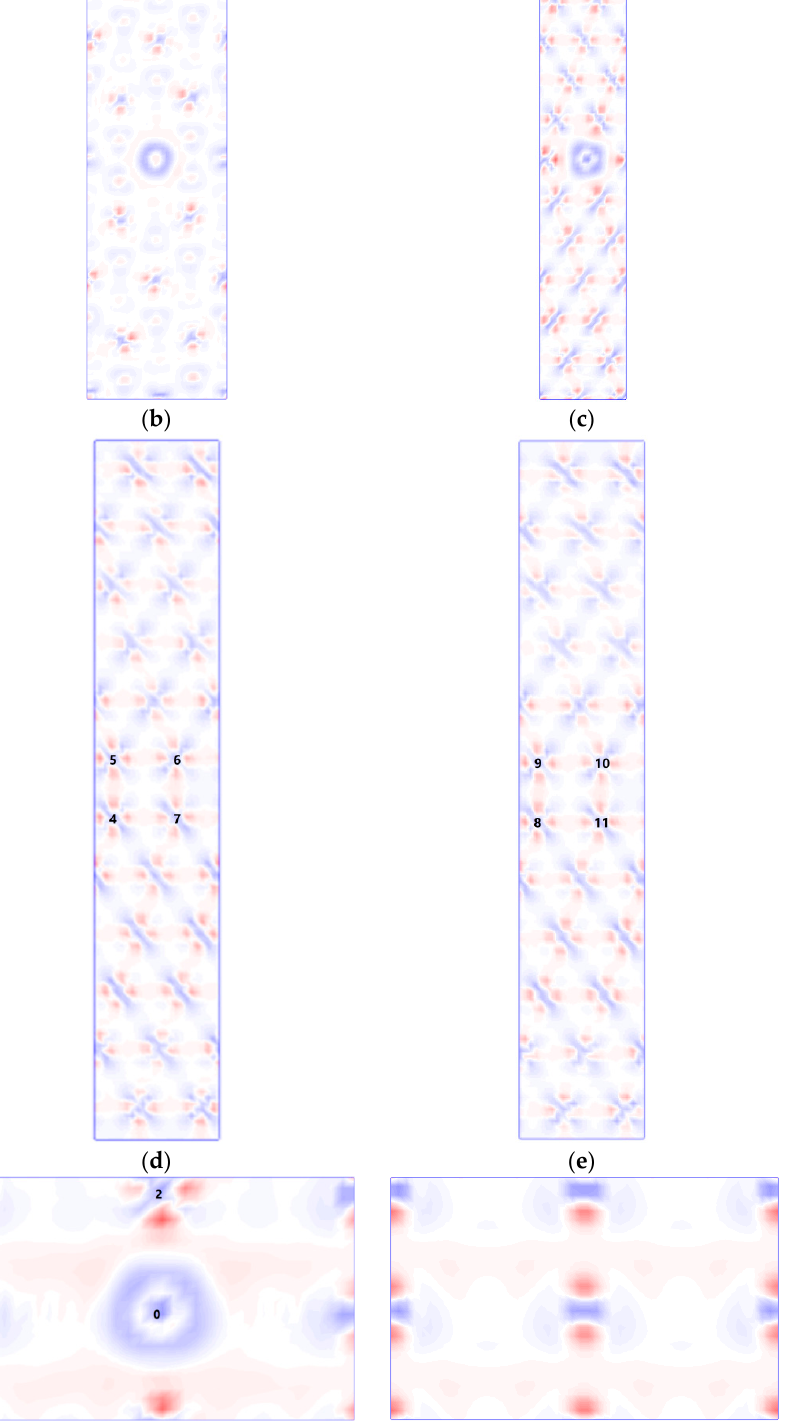
Figure 1. ( a ) The atomic configurations of bcc Fe for Σ 3[110] (112) grain boundary, the charge density difference on the Nb-doped ( b ) (110) plane, ( c ) (111) plane, ( d ) (111) plane, ( e ) (111) plane, and ( f ) (112) plane and Nb-undoped ( g ) (112) plane of α Fe Σ 3[110] (112) grain boundary: red indicates the inflow of electrons; blue indicates the outflow of electrons.